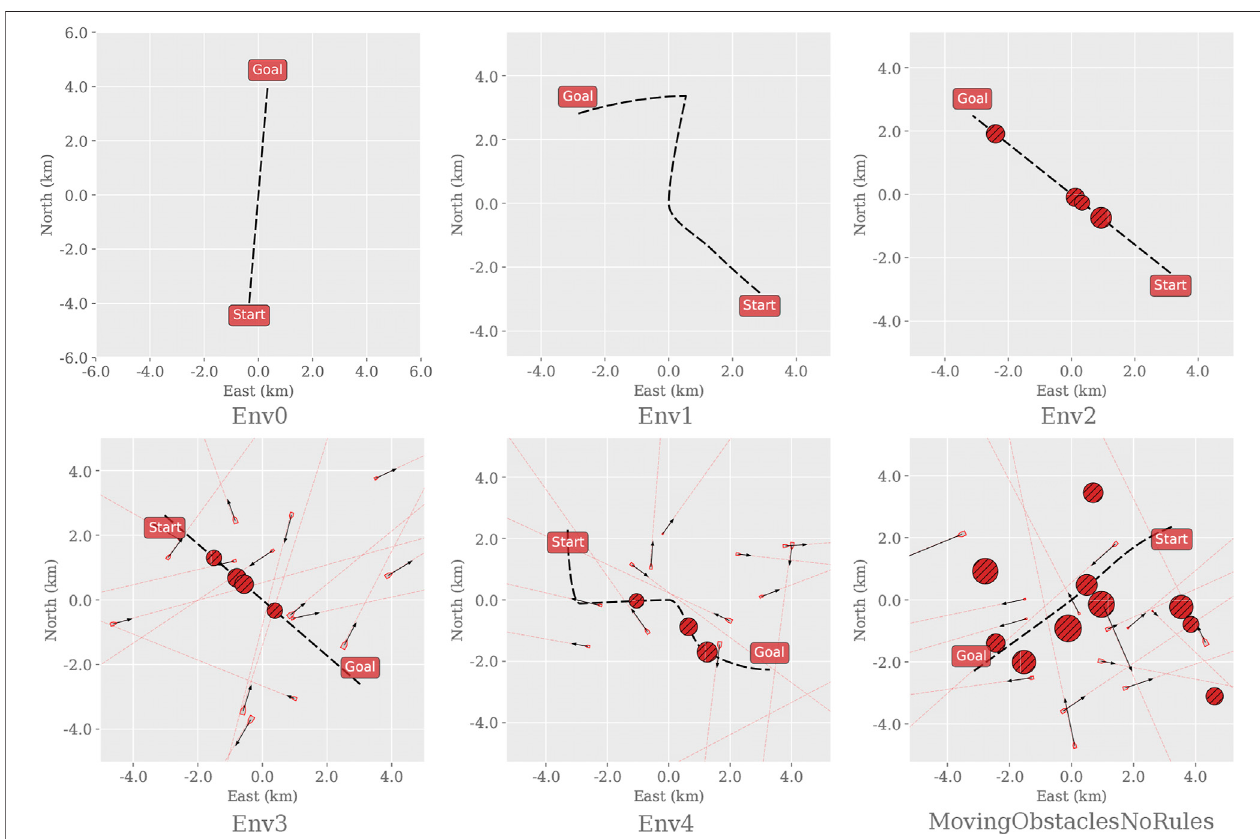
FIGURE 1 | Instances of each training environment used to evaluate the applicability of different RL algorithms on the dual task of path following and collision avoidance. Before de fi ning the path, the start and goal positions are initialized at random but with a fi xed distance (8000 m ) apart. Env0, the trivial case, contains only a straight path. Env1 creates a curved path. Env2 inherits Env0 and places 4 static obstacles randomly along the path. Env3 inherits the properties of Env2 and adds 17 dynamic obstacles with random headings, sizes, and velocities around the path. Env4 inherits Env3 and adds curvature to the path. Finally, MovingObstaclesNoRulesincreasesthenumberofstaticobstaclesfrom4to11andscattersthemrandomlyonandaroundthepath;thisrepresentstheoriginaltraining environment as de fi ned in Meyer et al. (2020b).